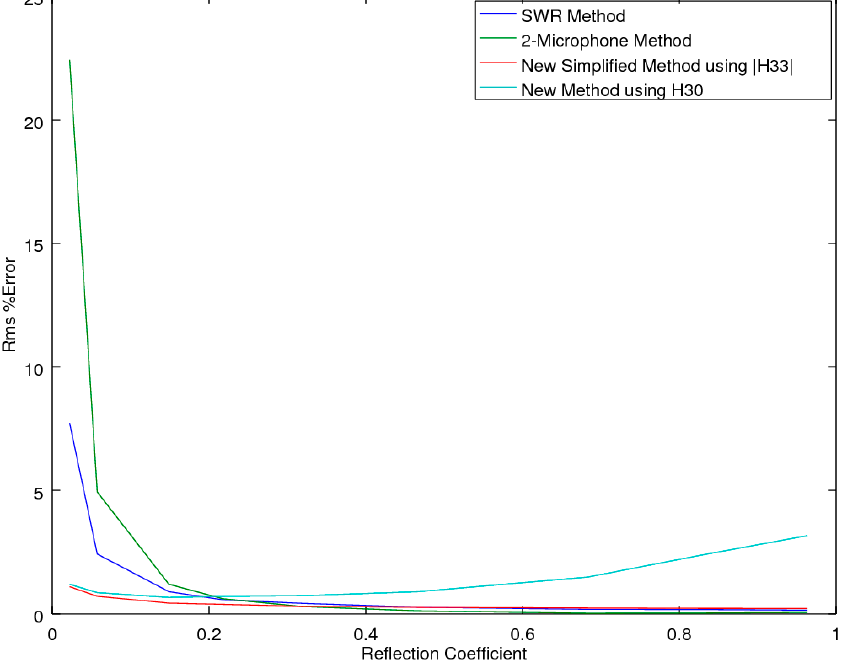
Figure 7. Comparison of accuracy from the computation of R, with a normalized noise level of 0.005 and a β value of 5.25. Comparison is between the two standard methods, SWR [2] and the two- microphone method [5,6], and the technique utilized in the three-microphone method [14], versus the new proposed methods utilizing the simplified |H 33 | method (amplitude only measurements) and